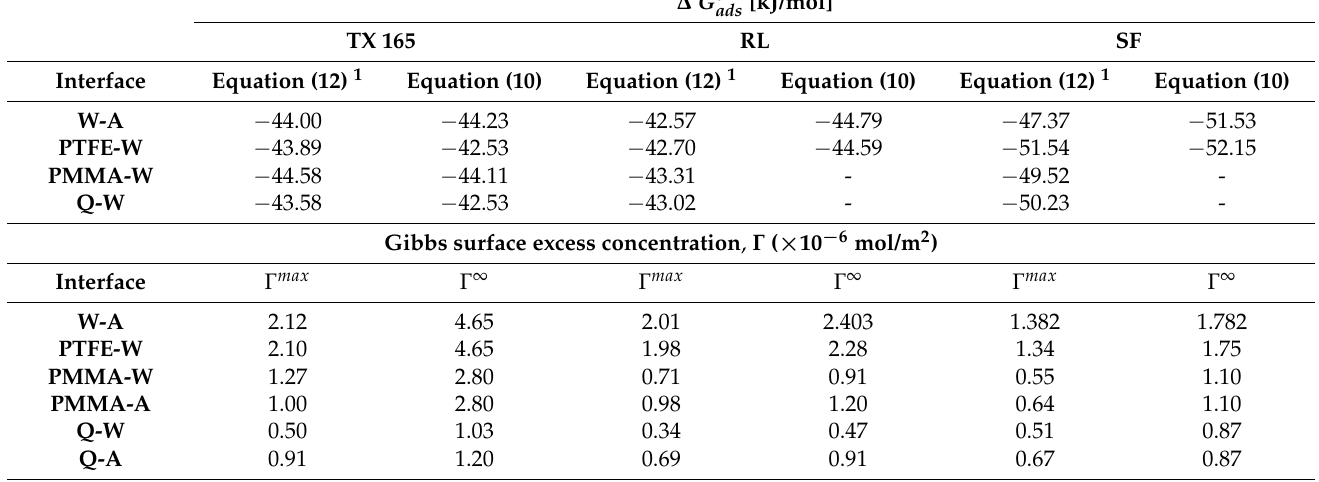
), Gibbs excess ads ∞ ) and the area occupied by TX165, RL and SF at the